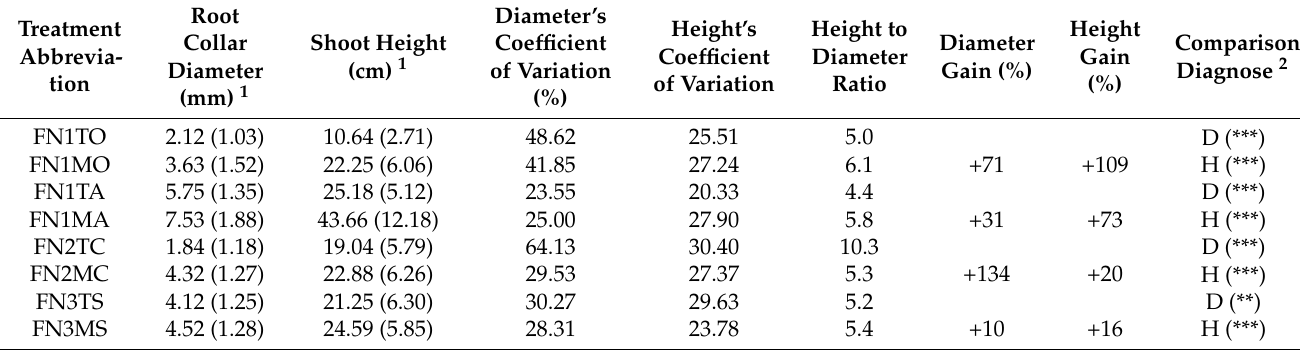
Table 5. Descriptive statistics and comparison tests of the shoot length and rood collar diameter.